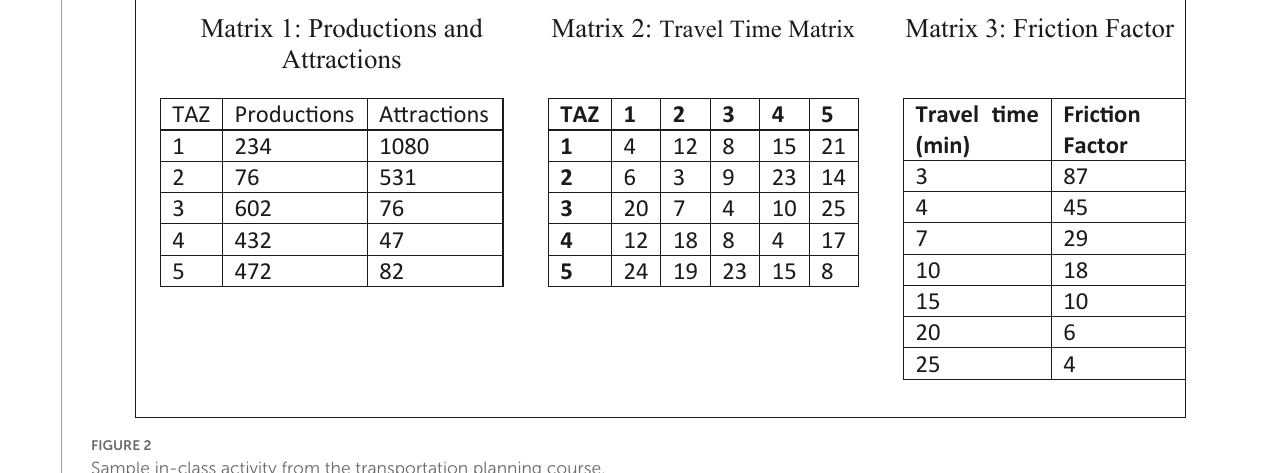
In-class Activity: To illustrate the application of the gravity model, consider a study area consisting of five zones. The data have been determined as follows: the number of productions and attractions has been computed for each zone as shown in Matrices 1, 2, and 3. Assume is the same unit value for all zones. Finally, the friction factor values are shown in Matrix 3 for each travel time increment. Determine the number of zone-to-zone trips through two iterations.